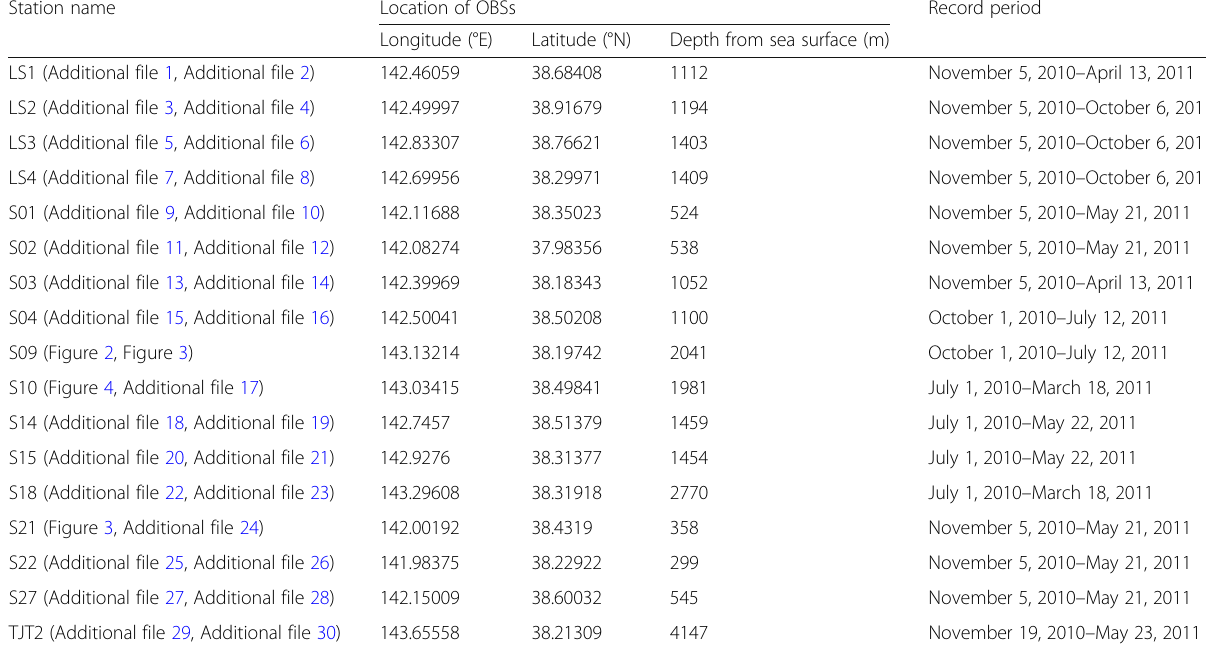
Table 1 Location and recording period of each OBS. We measured the locations of LS1 and S03 when they were collected, and the locations of other stations when they were set